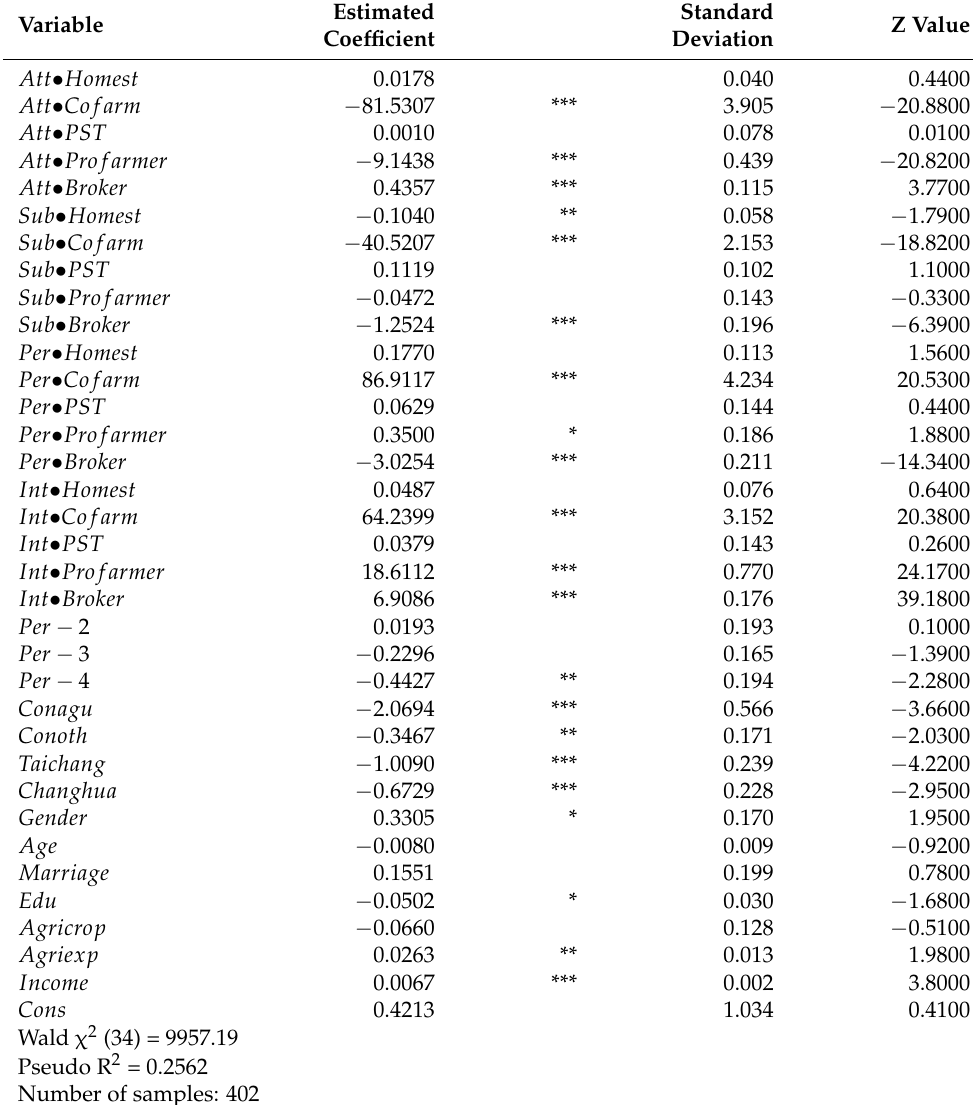
Table 3. Estimation results for farmers’ contract participating in the past three years.